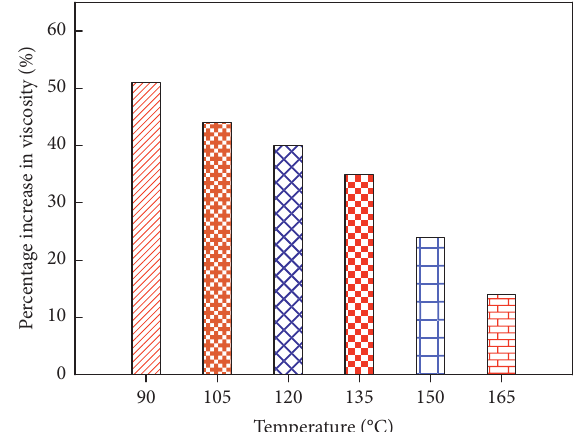
Figure 4: Percentage increase of viscosity comparing the 9% polymer-modified binder to the virgin